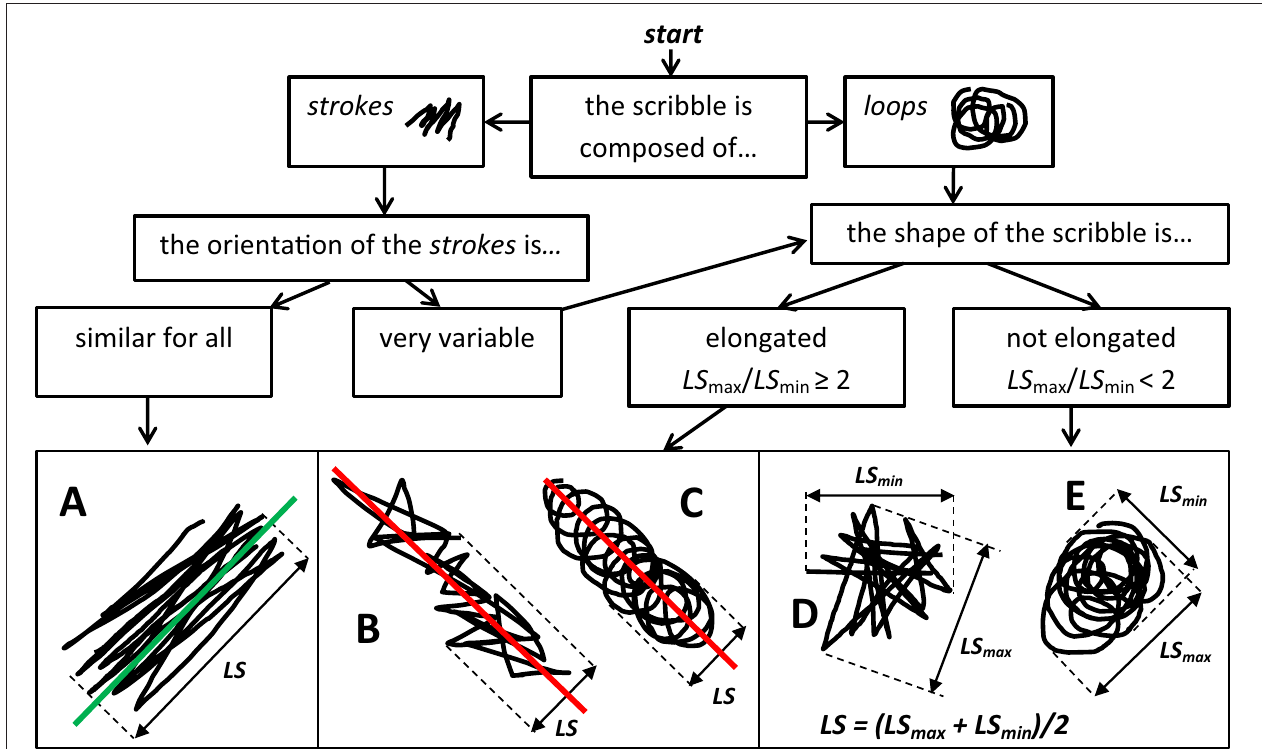
FIGURE 1 | Flowchart for deciding along what direction the linear size ( LS ) of a scribble should be measured. (i) If the scribble is composed of (roughly linear) strokes that are all oriented in a similar way (as in A ), the scribble has most likely been produced by a distal oscillatory movement along the direction of the strokes (green line in A ), combined with a transportation component orthogonal to it; hence LS should be measured along the green line (the likely direction of the distal component). (ii) If the scribble is not a set of well-aligned strokes as in A , another clue is the scribble’s shape: if this is elongated (as in B , C : its maximum linear size LS max is more than twice its minimum linear size LS min ) the transportation component likely acted along its major axis (red lines); in order to minimize the impact of the transportation component, LS will be measured